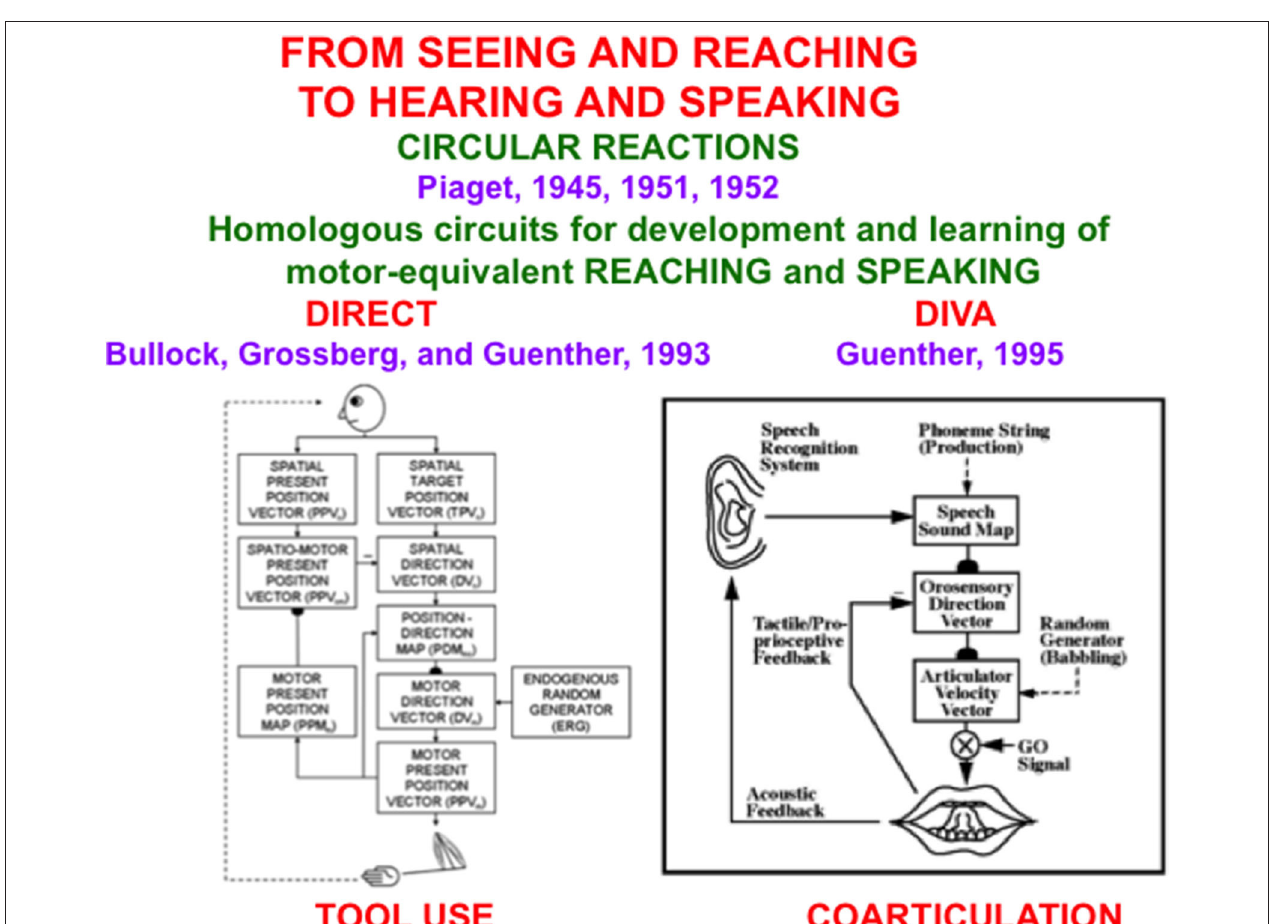
FIGURE 14 | The DIRECT and DIVA models have homologous circuits to learn and control motor-equivalent reaching and speaking. Tool use and coarticulation are among the resulting useful motor-equivalent properties [reprinted with permission from Grossberg